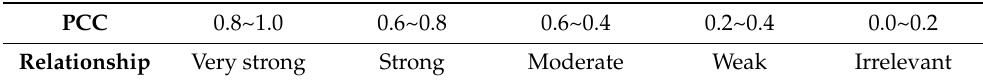
Table 2. The relationship between PCC and correlation